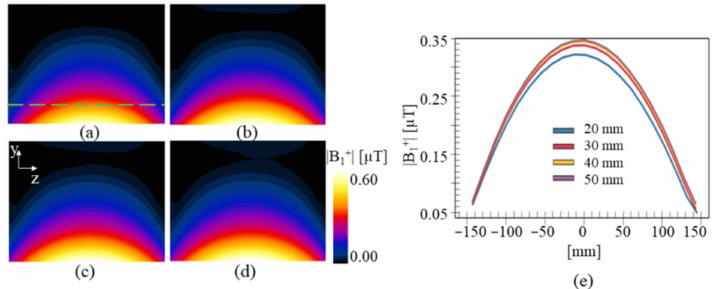
Figure 3. Computed |B 1+ |-field for microstrips with dielectric heights of ( a ) 20, ( b ) 30, ( c ) 40, and ( d ) 50 mm. The field profile for each of the computed |B 1+ |-fields is depicted in ( e ).